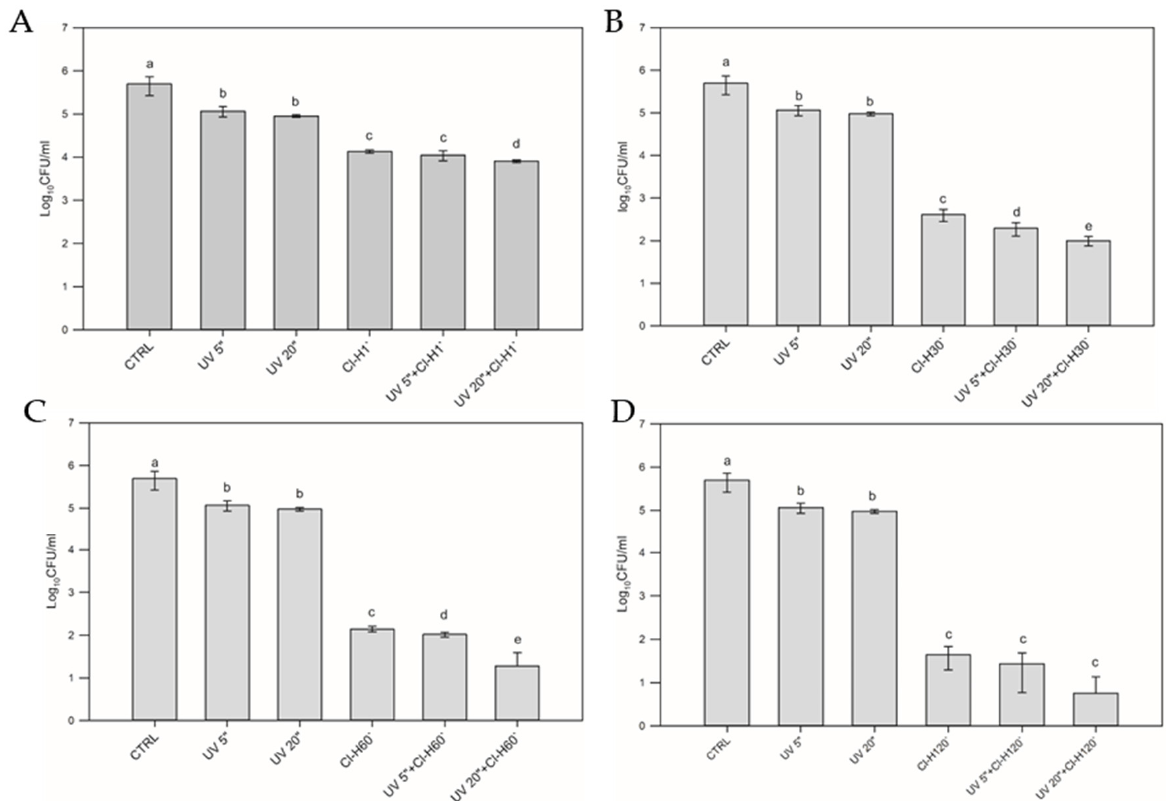
Figure 4. Destruction of a 5-day-old biofilm (log 10 CFU/mL) after treatment with UV 5 (UV 5”) and 20 s (UV 20”), and hyperchlorination (Cl-H) for ( A ) 1 min, ( B ) 30 min, ( C ) 60 min and ( D ) 120 min and their combinations. The control is represented by an untreated biofilm. The mean values are shown along with the standard deviations. Lowercase letters above the results indicate the statistical significance. The same letters indicate that there is no statistically significant difference between groups while different letters indicate a statistically significant difference tested by Students t -test and by Mann–Whitney U test for UV 20” vs. UV 5”; Cl-H120’ vs. UV 20” and UV 20” + Cl-H120’ vs. UV 5” + Cl-H 120’.